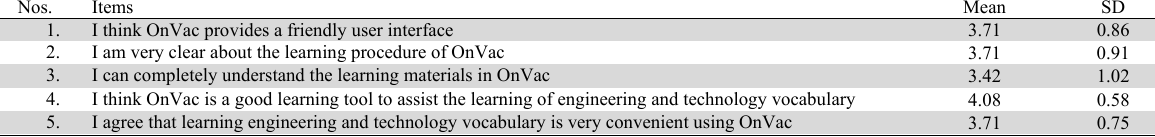
Results of learners' levels of satisfaction in terms of system operations playing OnVac